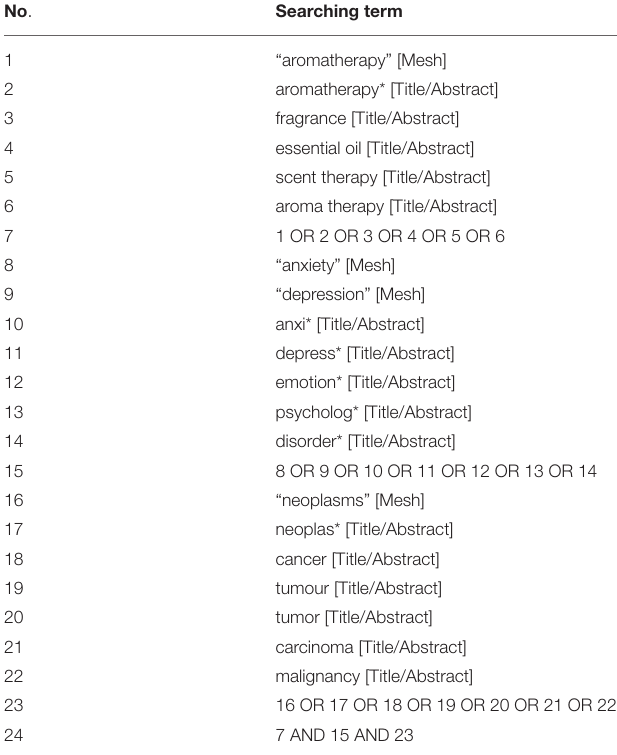
TABLE 1 | Searching strategy in